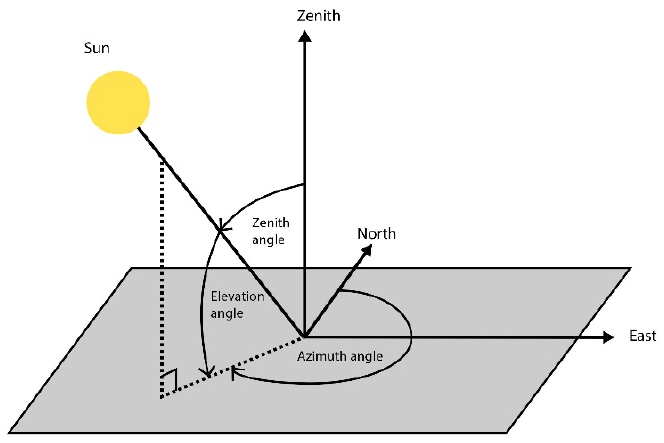
Figure 5. Representation of azimuth and zenith angles.